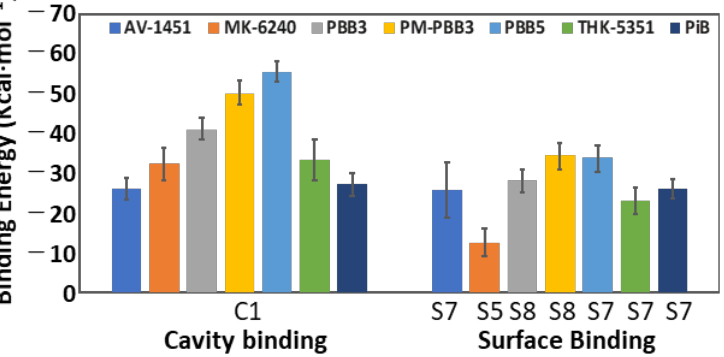
Figure 6. MM/GBSA binding energies of PET probes in site C1 and surface binding sites that show the most potent binding (S1–S11).